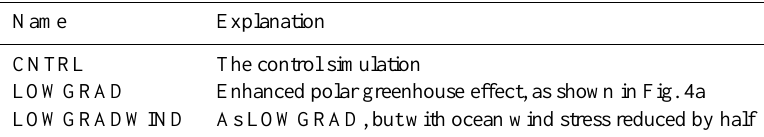
Table 1. Description of numerical equilibrium simulations.